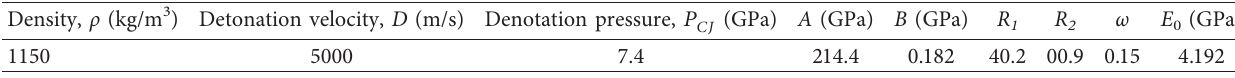
Table 3: Physical and mechanical properties of rock-soil used in the numerical simulation. Table 4: Material parameters of the emulsion explosive material and state parameters of the JWL equation.